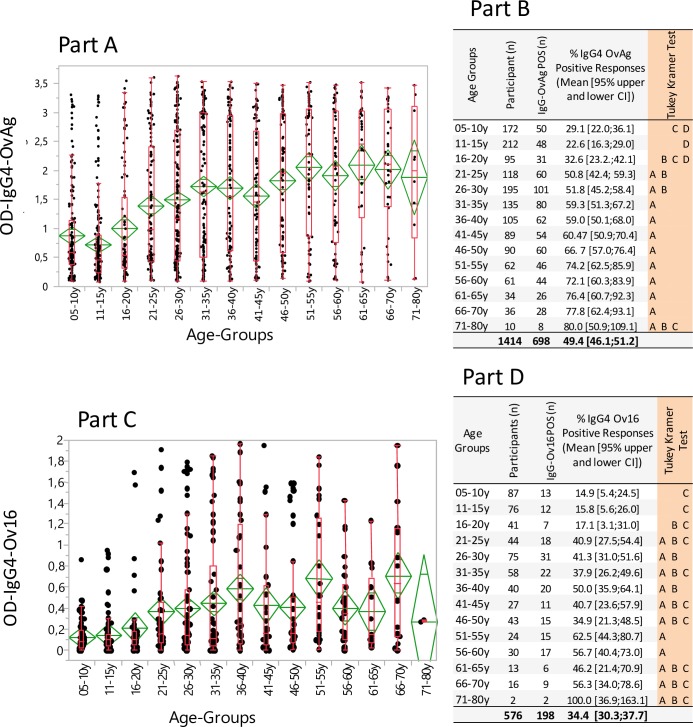
Onchocerca volvulus adult worm (OvAg) and recombinant Ov16 antigen-specific IgG4 reactivity (optical densities; OD) in participants and positive and negative IgG4 responses in age groups.In A and C the data on antigen-specific IgG4 reactivity are shown as mean optical densities (ODs) with 95% confidence intervals for the means (diamonds). The data presented in box plots show the median OD per age group with the 25% and 75% quartiles and the 1.5x of the interquartile range. In B and D the antigen-specific-IgG4 positive and negative responses in age groups are indicated (in %).